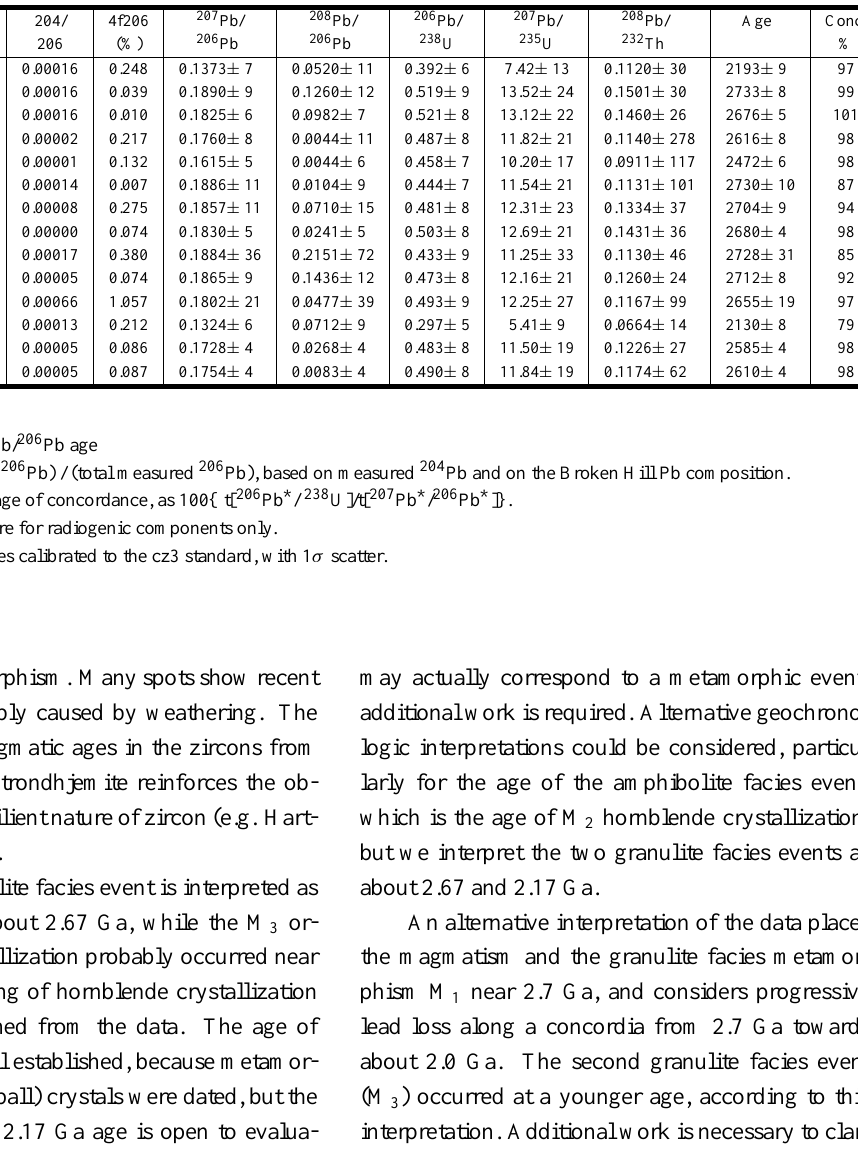
SHRIMP zircon isotopic data of Santa Catarina granulite, sample